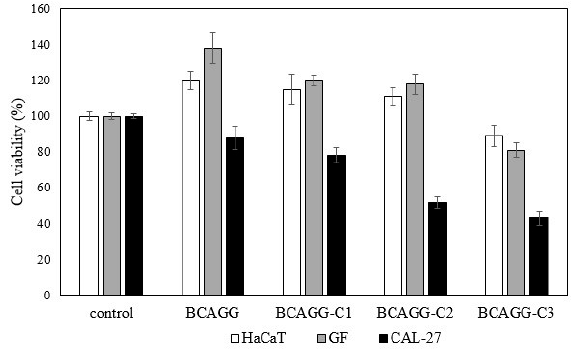
Figure 6. Cell viability (%) of HaCaT, GF and CAL-27 at 48 h after seeding.